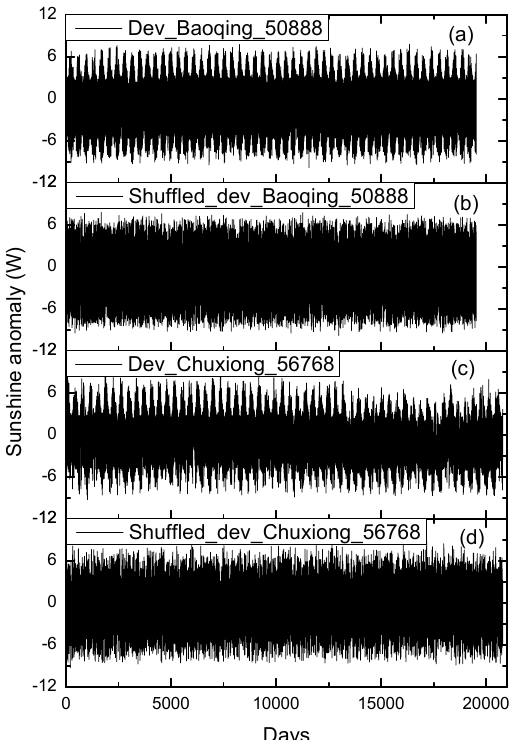
Figure 1. Temporal evolutions of the SSDA during the time from 1954 to 2009 at station Baoqing and Chuxiong. ( a ) Station Baoqing before shuffling the SSDA. ( b ) Station Baoqing after shuffling the SSDA. ( c ) Station Chuxiong before shuffling the SSDA. ( d ) Station Chuxiong after shuffling the SSDA.